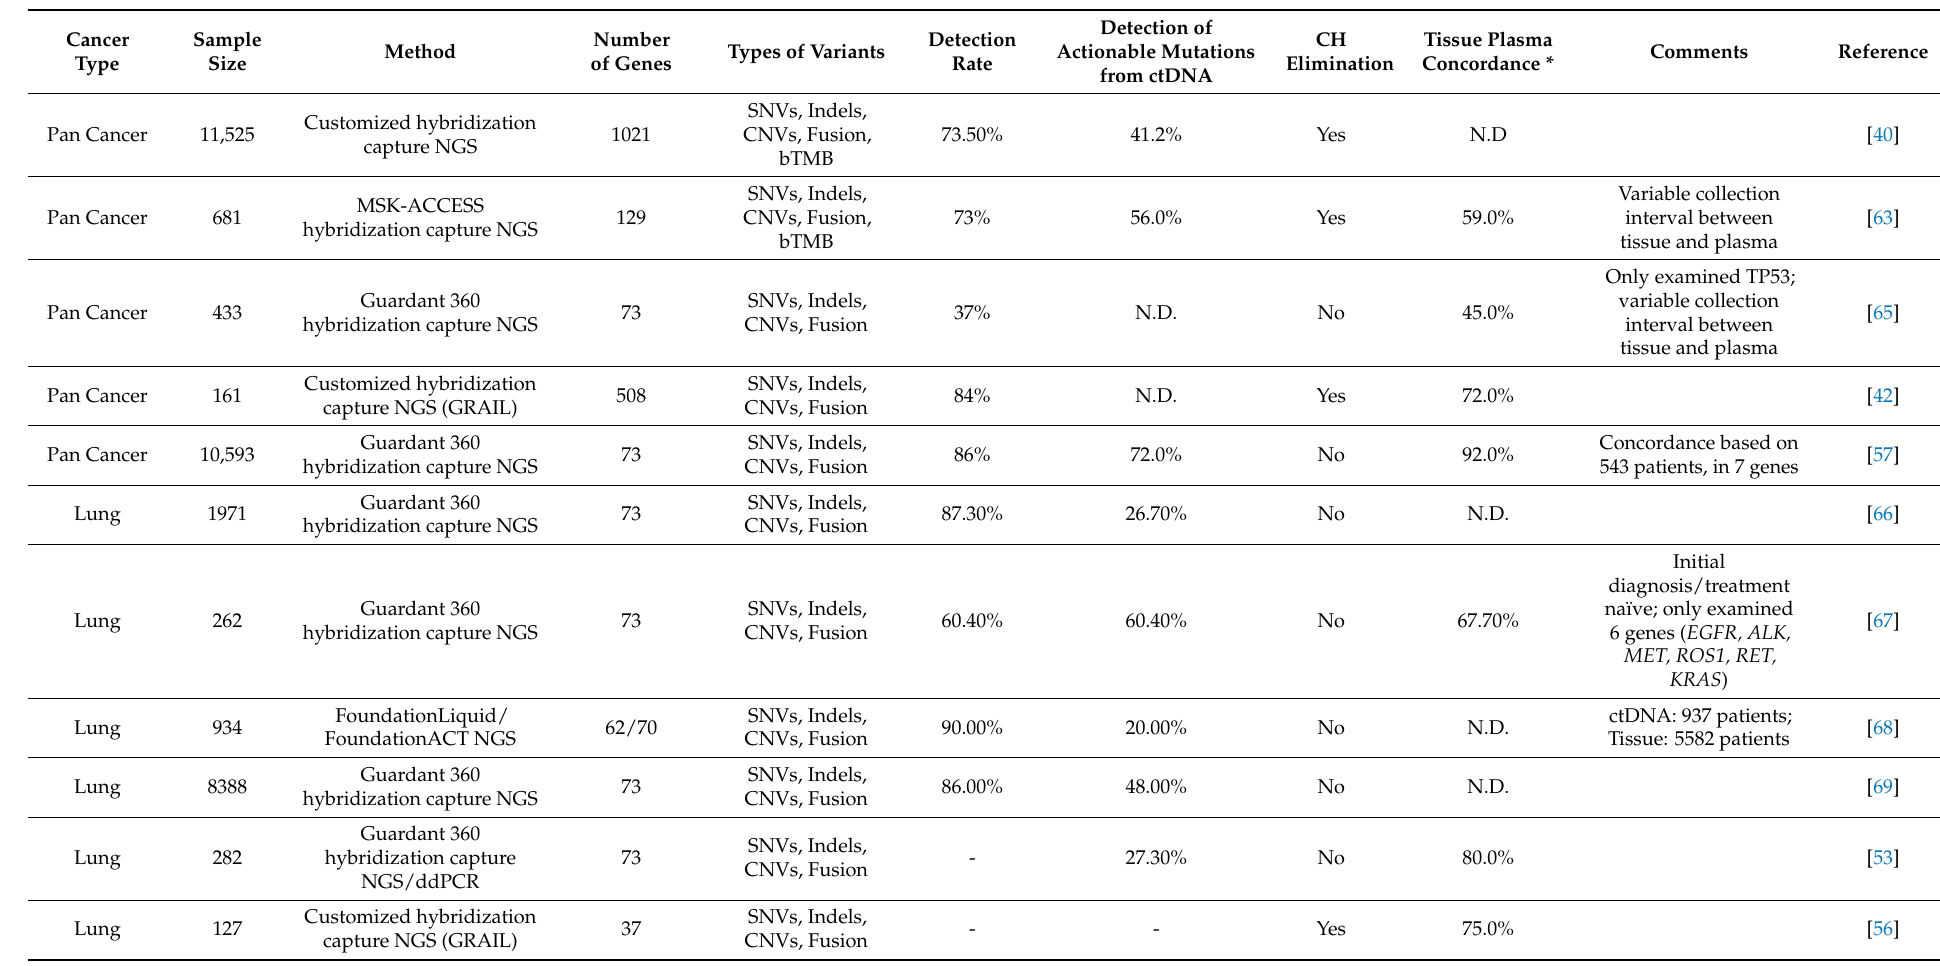
Table 2. Summary of recently published studies on the mutation detection concordance between tumor tissues and